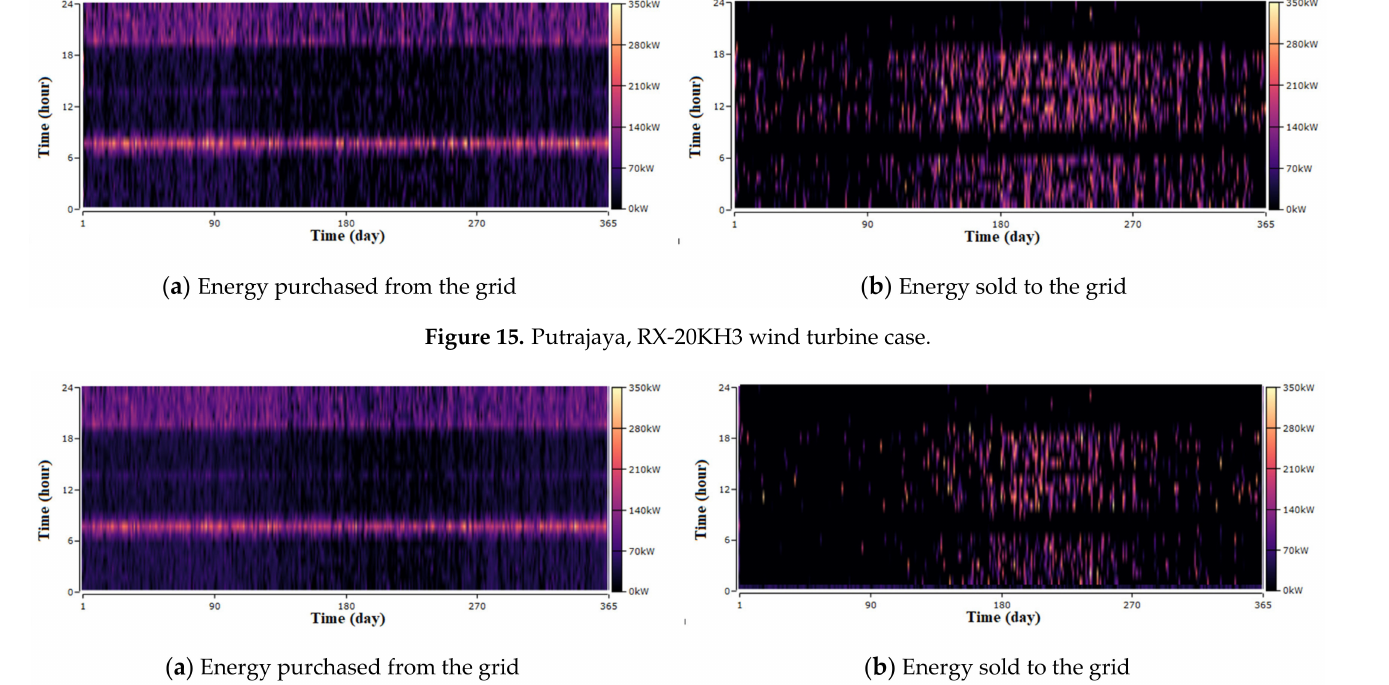
Figure 16. Putrajaya, WES80 wind turbine